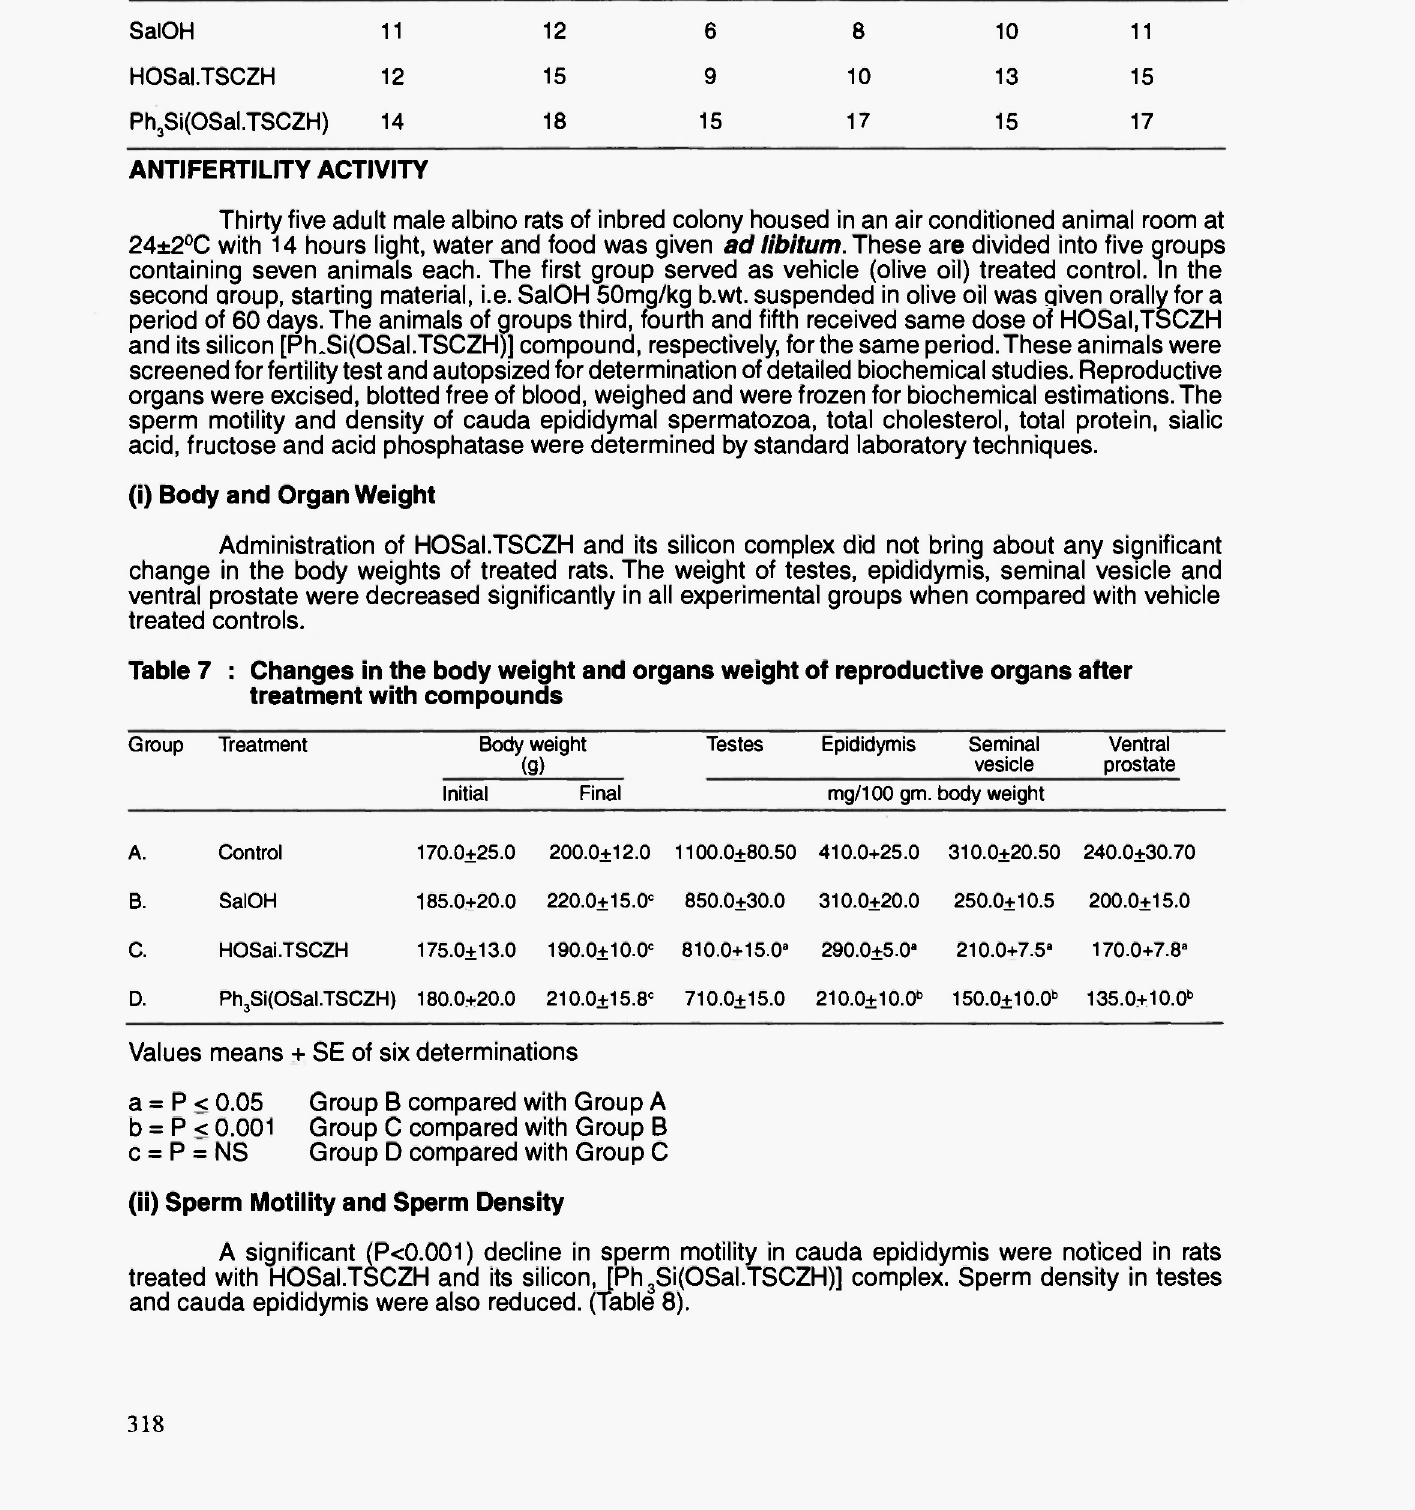
: Antibacterial activity of the SalOH, HOSai.TSCZH and Ph Si complex Compound